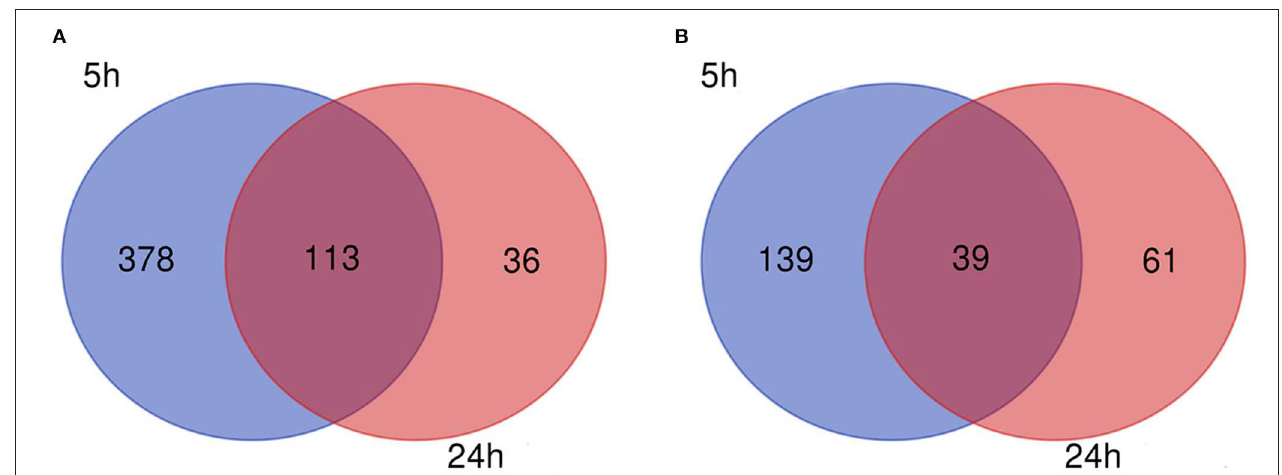
FIGURE 3 | Venn diagram. (A) Downregulated and (B) upregulated